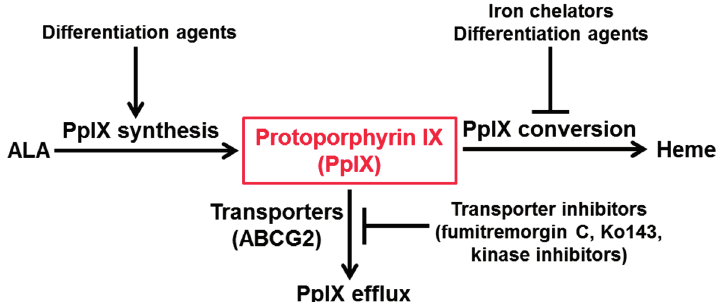
Figure 2. Current therapeutic strategies for enhancing ALA-based tumor detection and therapy. These strategies include enhancing PpIX synthesis, reducing PpIX conversion and inhibiting PpIX